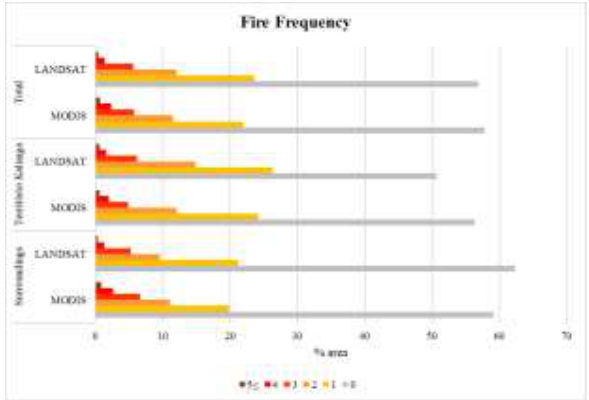
Figure 3. Comparison of the fires frequency, inside and around the TKG, based on MODIS and LANDSAT products.